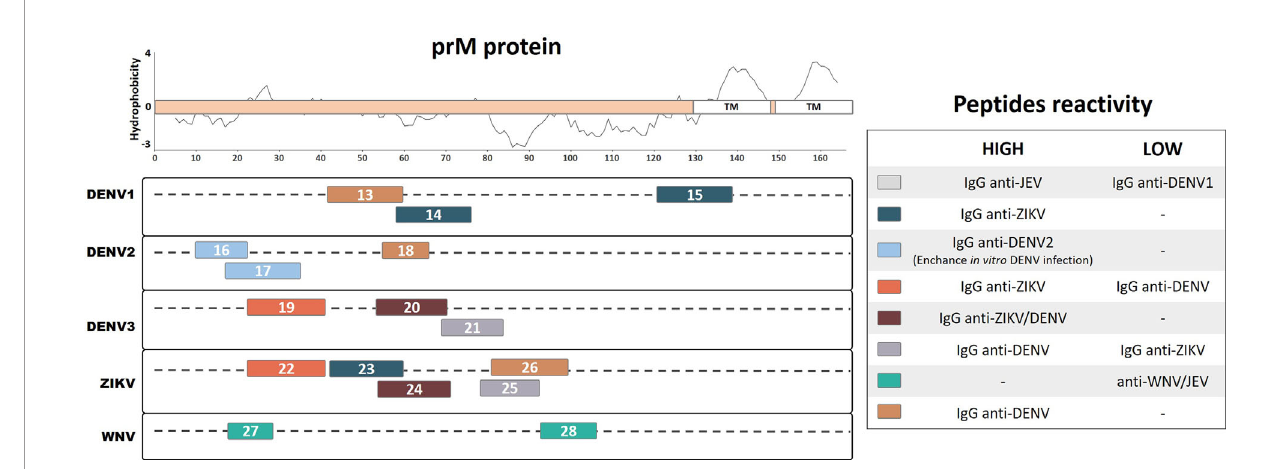
FIGURE 2 | Linear representation of the fl avivirus prM protein with representative topology and hydrophobicity prediction determined based on the ZIKV entry query of Uniprot Q32ZE1. Linear peptides are labeled by numbers and the antibody reactivity indicated by colors. The hydrophobicity prediction pro fi le was determined using the amino acid sequence of the ZIKV (Genbank YP_002790881) with the Kyte & Doolittle hydropathy score scale (J. Mol. Biol. 157:105-132(1982). TM, Transmembrane